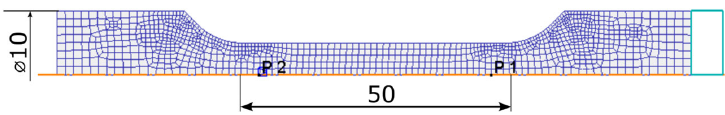
Figure 1. Geometry used for the modeling of tensile test.